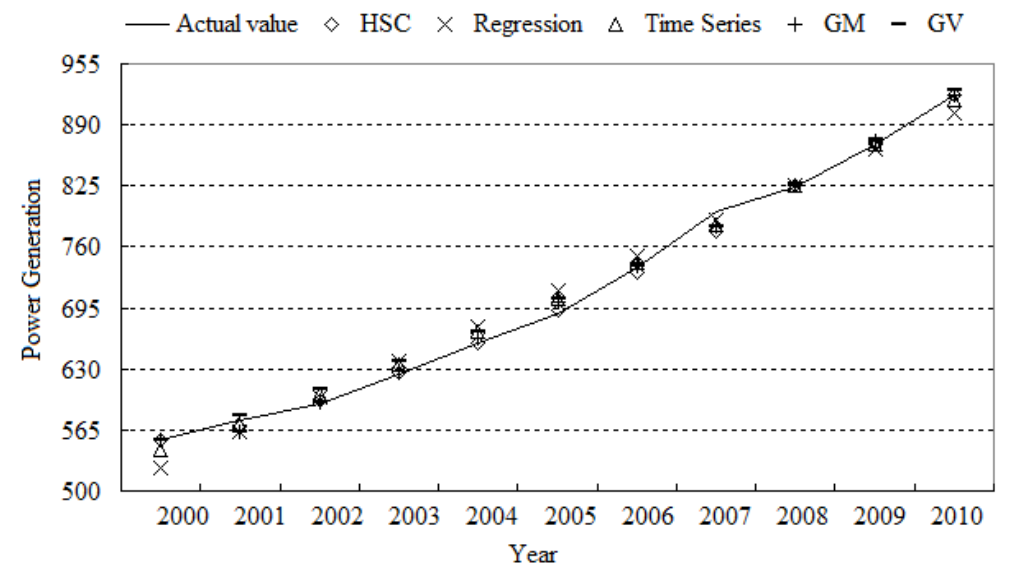
Figure 5. Forecasting performance of the HS-based JPOC model and the other four single models for